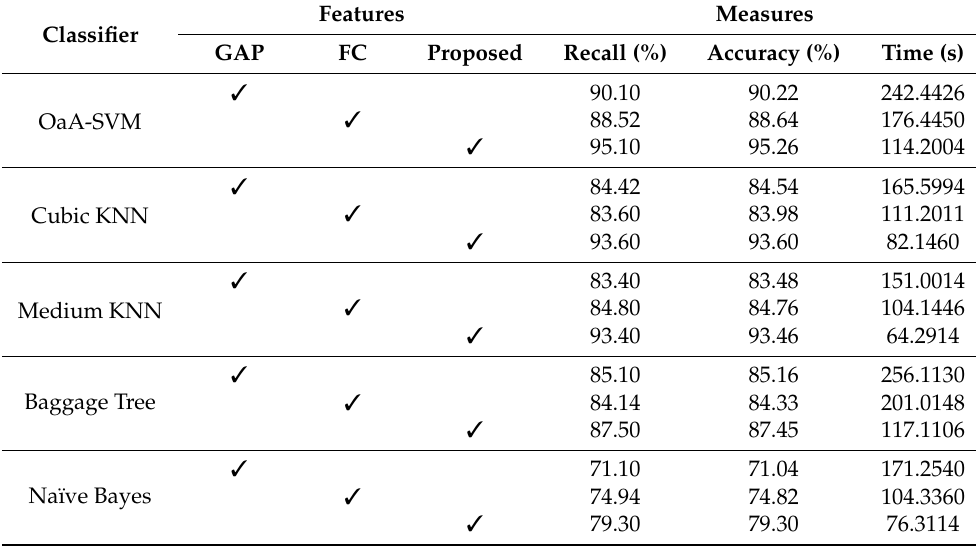
Table 4. Proposed recognition results on CASIA B dataset, where selected angle is 90 ◦ .